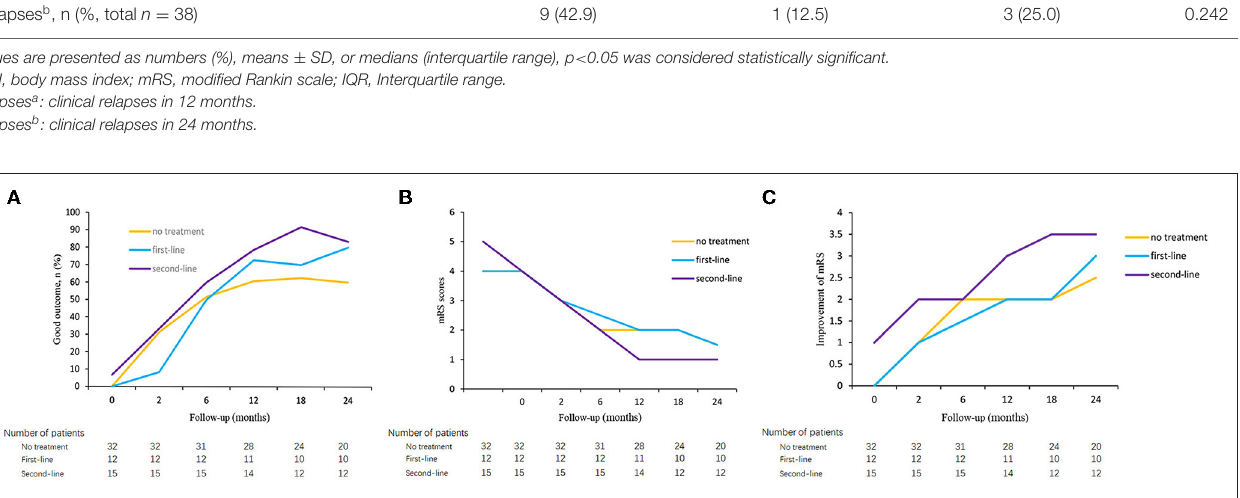
FIGURE 3 | Clinical outcome in autoimmune encephalitis patients who failed short-term first-line treatment. Good outcome of patients who failed first-line treatment in three groups (A) , mRS score of patients who failed first-line treatment in three groups (B) , and improvement of mRS score of patients who failed first-line treatment in three groups (C)